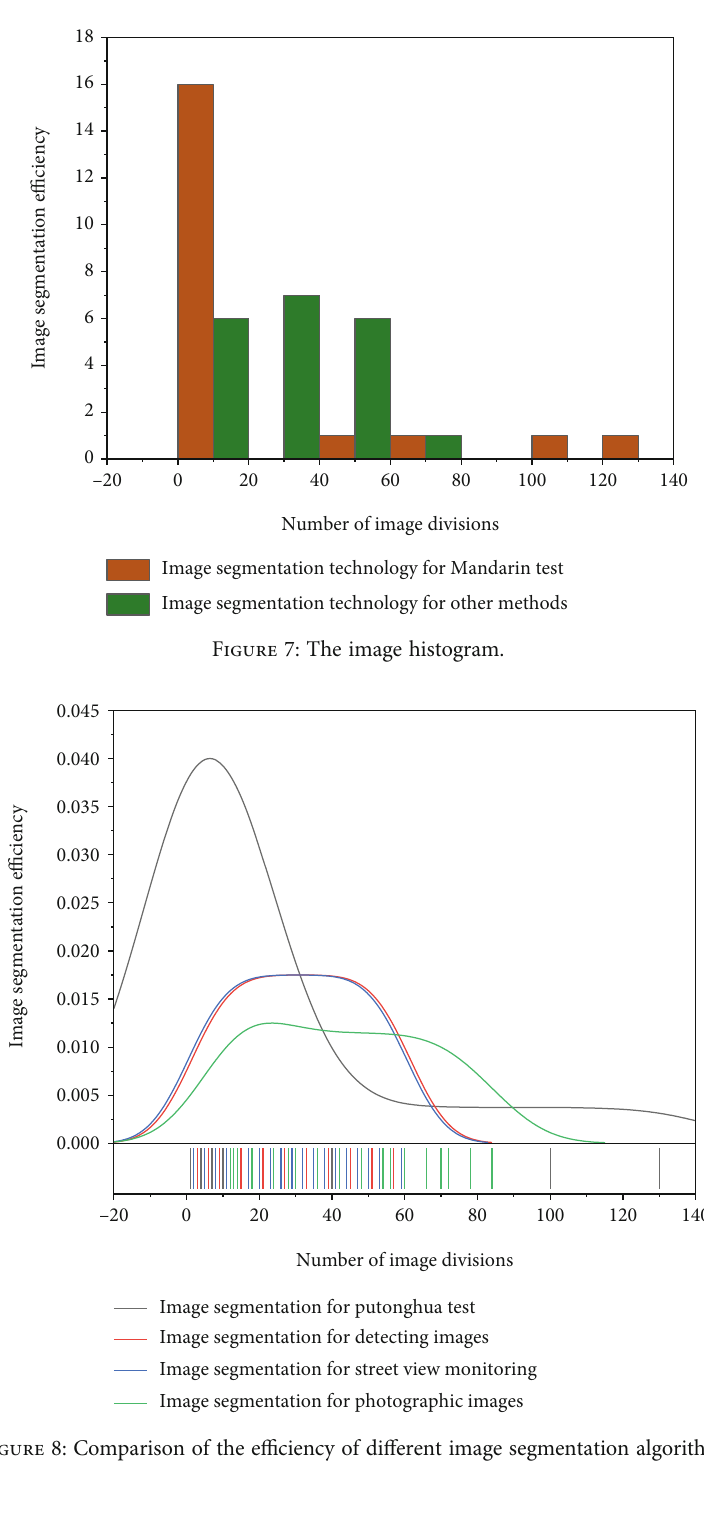
Figure 8: Comparison of the e ffi ciency of di ff erent image segmentation